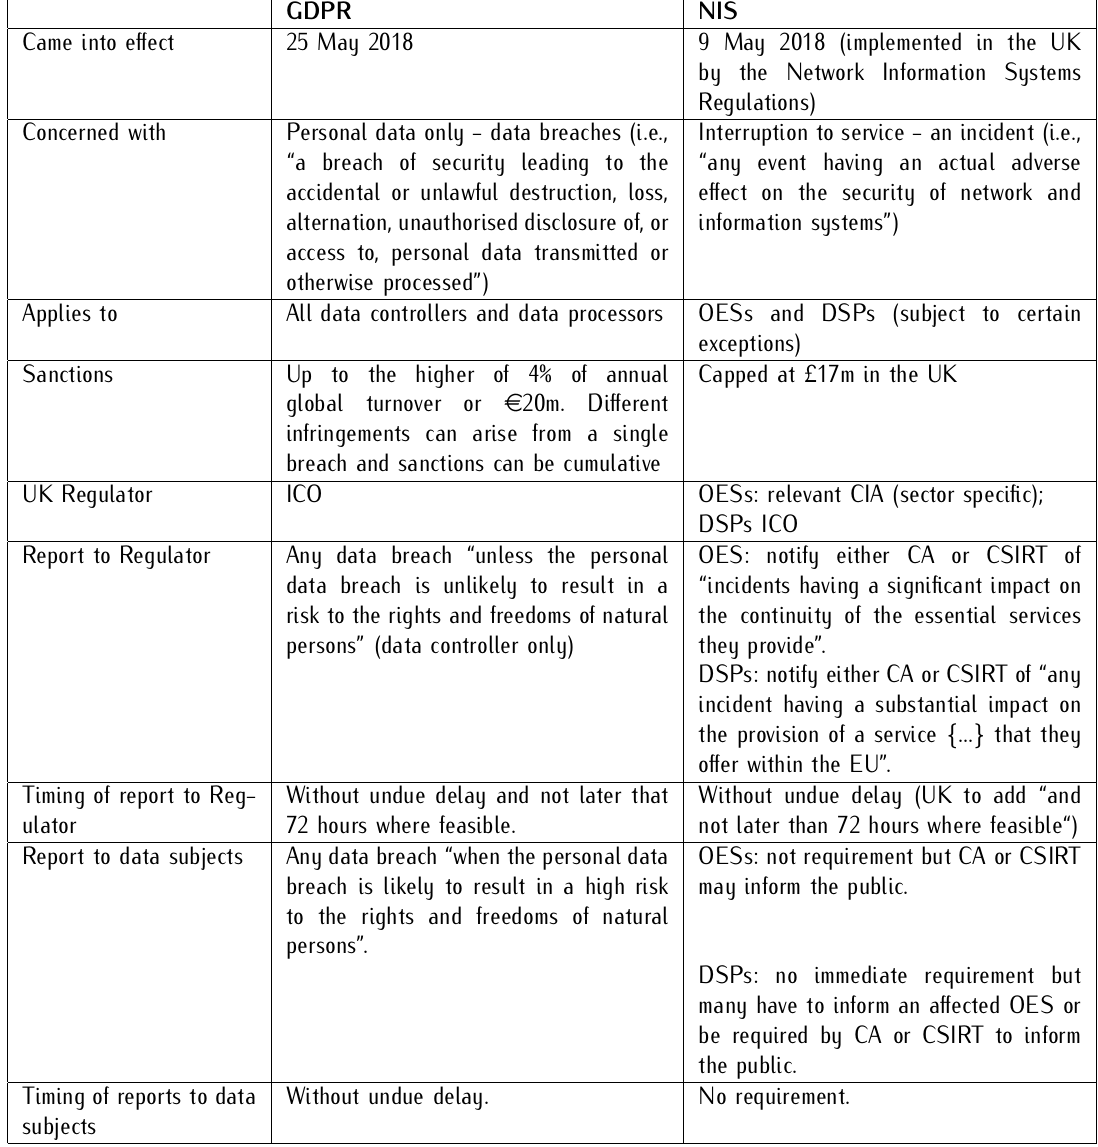
Table 2. Differences between GDPR and NIS